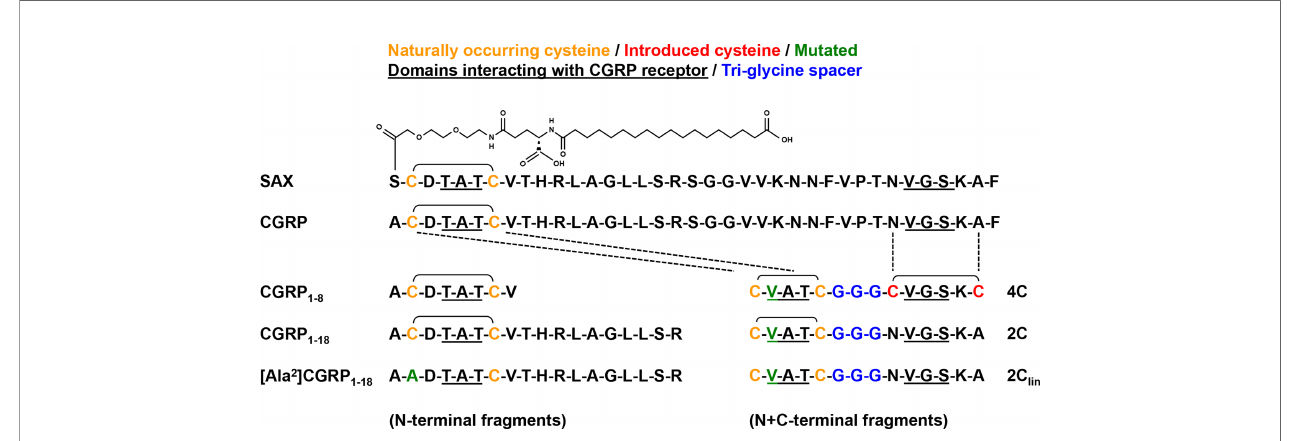
FIGURE 2 | Sequences of CGRP, SAX and CGRP fragments. Amino acid sequences of the different agonists used in the current study, including full-length native CGRP; the long-acting metabolically stable CGRP analogue SAX; the N-terminal fragments CGRP 1 – 8 , CGRP 1 – 18 , and control mutated [Ala 2 ]CGRP 1 – 18 ; the bivalent N+C-terminal fragments 4C, 2C, and control 2C lin lacking disul fi de